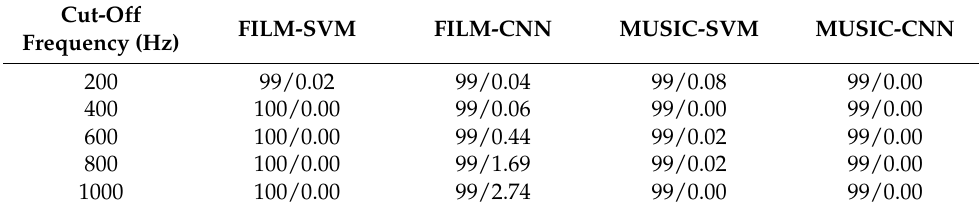
Table 3. ACC and FAR of the 1st model with various f cof (%).